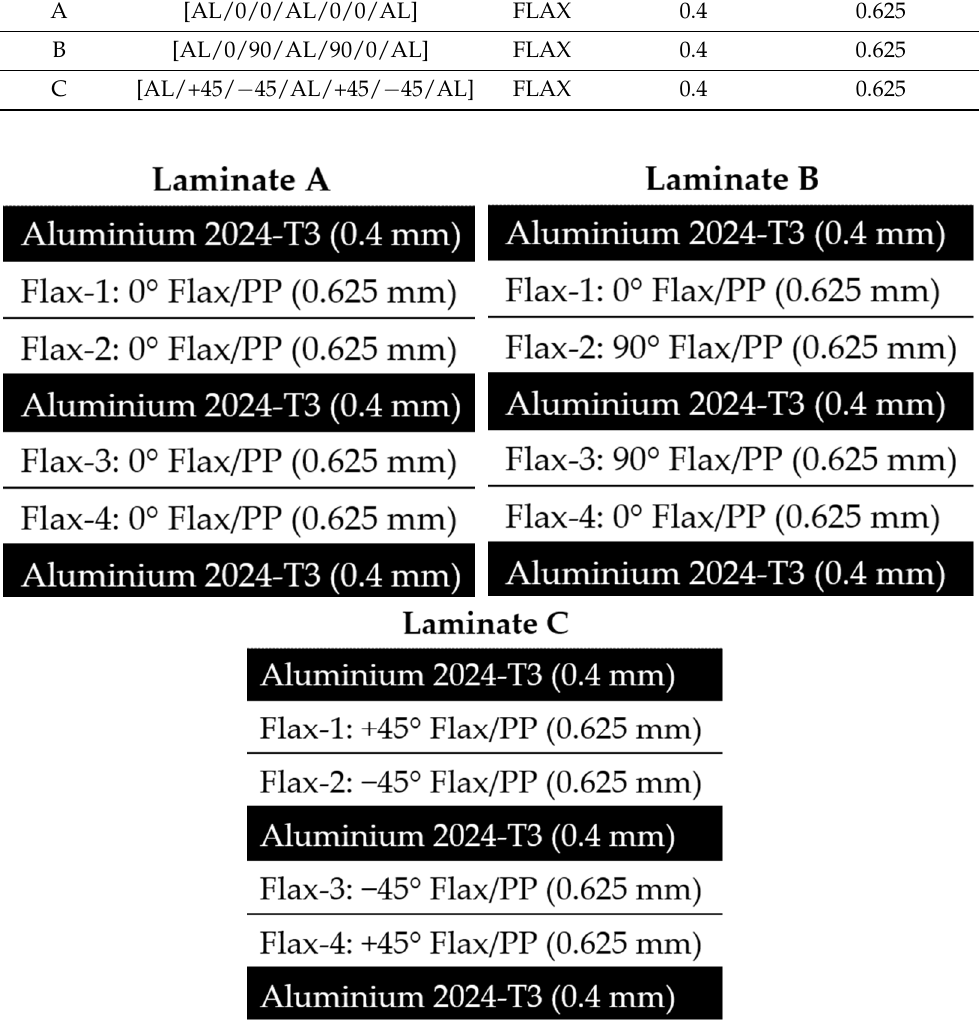
Figure 2. The various layup of Aluminium/Flax fibre metal laminates.